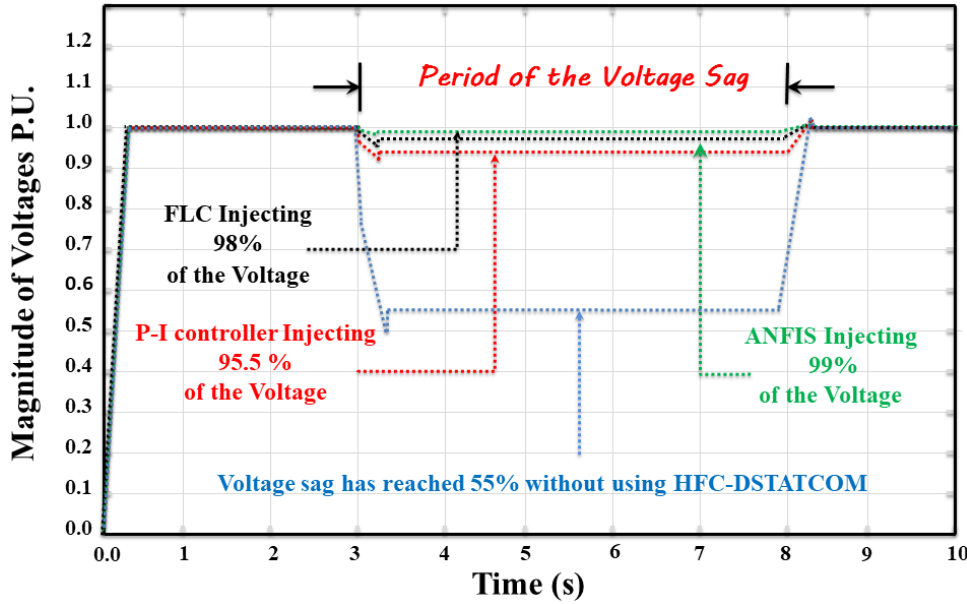
Figure 20. The injection voltage by HFC D-STATCOM due to the two Line-to-Ground Faults Scenario. has reached 0.55 p.u. due to the two line-to-ground faults scenario. HFC